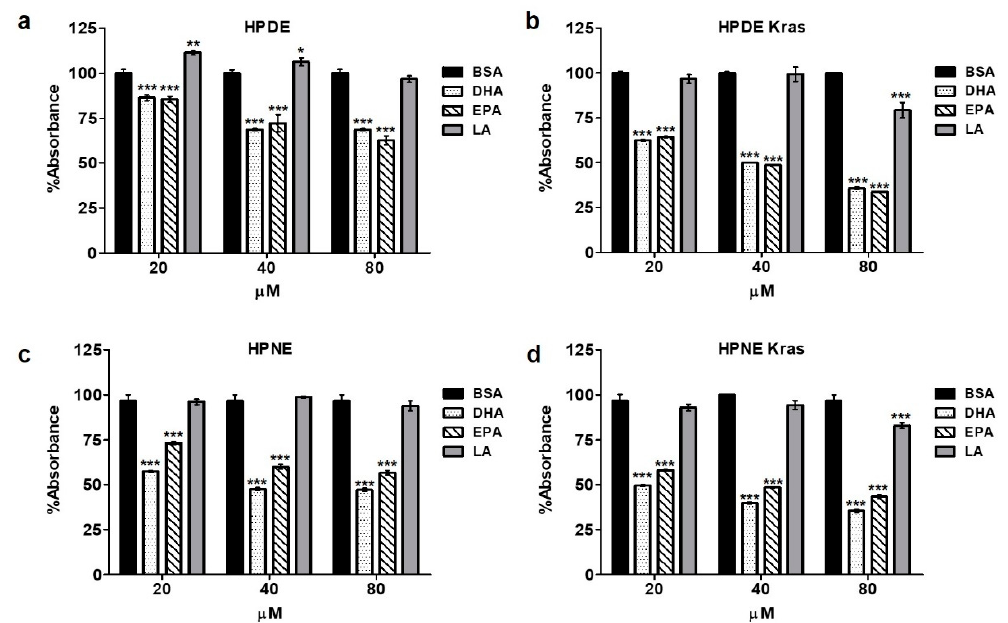
Figure 3. ω 3 fatty acids inhibit cell viability in vitro. ( a ) Human pancreatic ductal epithelial (HPDE) cells were administered increasing concentration of either ω 3 fatty acids Docosahexaenoic Acid (DHA) and Eicosapentaenoic acid (EPA), or the ω 6 fatty acid Linoleic acid (LA) in vitro. Proliferation was then assessed by 3-(4,5 dimethylthiazol-2yl)-2,5-diphenyl-tetrazolium bromide (MTT) assay after 48 h, showing a similar reduction in proliferation in response to both ω 3 fatty acids. ( b – d ) The experiment was next repeated in HPDE with stable expression of mutant KRASG12D (HPDE-KRAS), as well as human pancreatic nestin-expressing (HPNE) cells and HPNE cells with stable expression of mutant KRASG12D (HPNE-KRAS). * p -value < 0.05: ** p -value < 0.01; *** p -value < 0.001. The asterisk above each column represent the significance compared to the control diet. The significance between both diet is indicated by connecting lines.